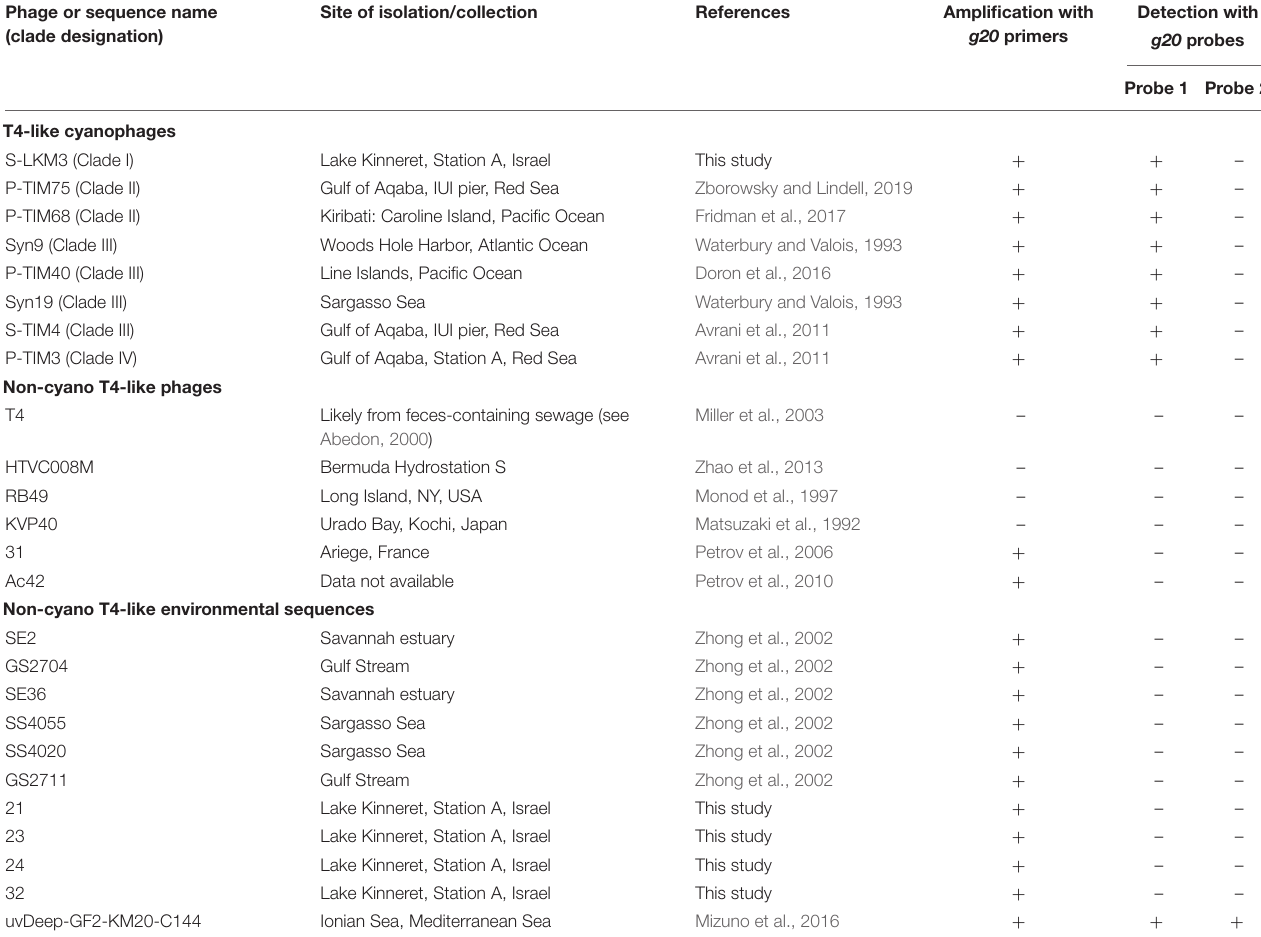
TABLE 2 | Specificity of primers and probes for polony detection of T4-like cyanophages. Phage or sequence name (clade